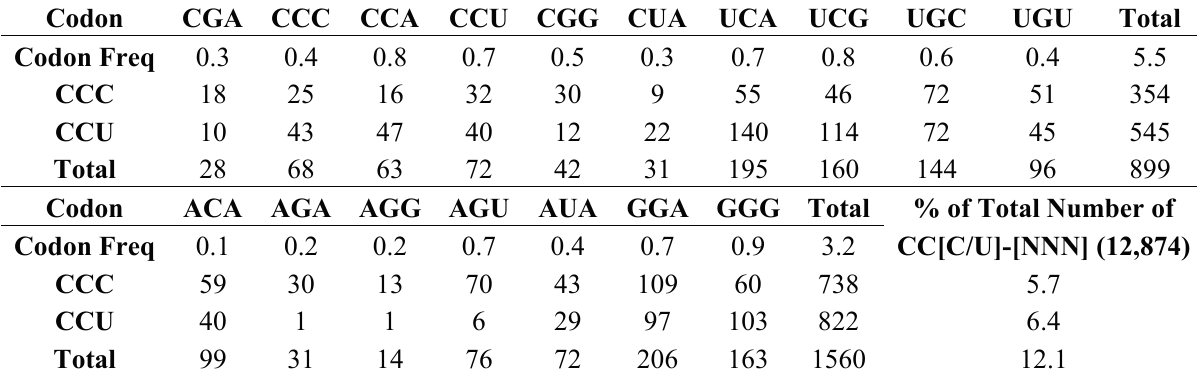
Table 1. The number of CC[C/U] codons followed by a rare codon in the E. coli K12 protein-coding